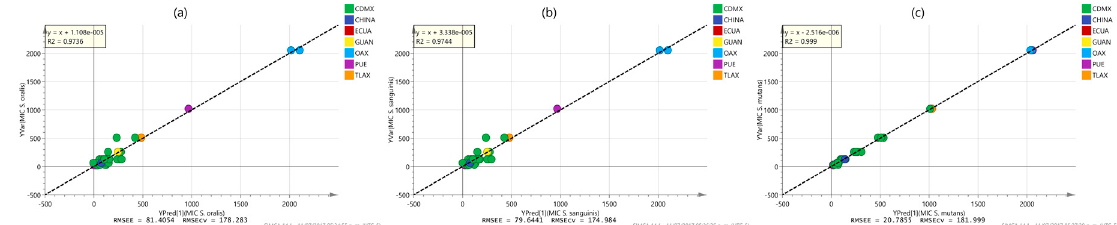
Figure 6. OPLS model observed vs. predicted antimicrobial MIC activity ( a ) S. oralis ; ( b ) S. sanguinis , and ( c ) S. mutants , plot of propolis samples labeled according to their origin: Mexico City (CDMX), Puebla (PUE), Oaxaca (OAX), Guanajuato (GUAN), Tlaxcala (TLAX), Ecuador (ECUA) and China (CHINA).